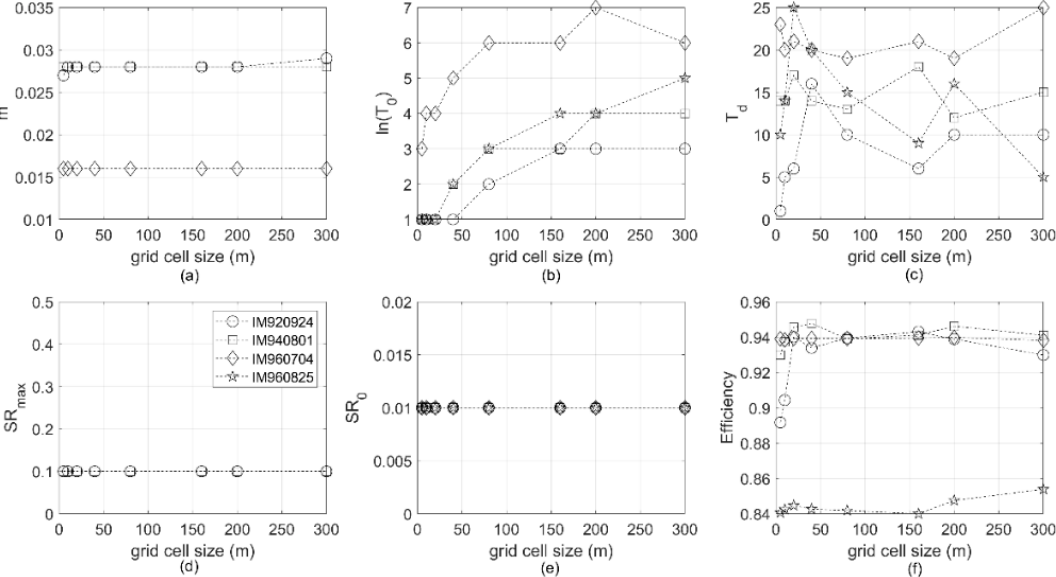
Figure 11. Optimized parameters depending on DEM resolutions in each hydrologic event, the Ieemokjung watershed. ( a ) exponential storage parameter (m), ( b ) soil–water permeability coefficient ( ln ( T 0 ) ), ( c ) unsaturated lag time ( T d ), ( d ) maximum vegetation storage ( SR max ), ( e ) Vegetation deficiency ( SR 0 ), ( f ) model efficiency.